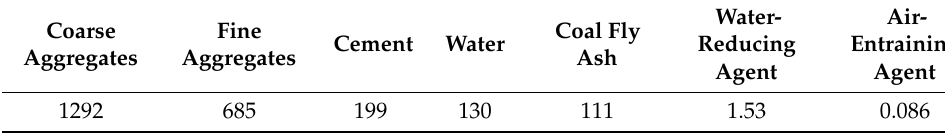
Table 6. Basic mix proportions (kg/m 3 ).